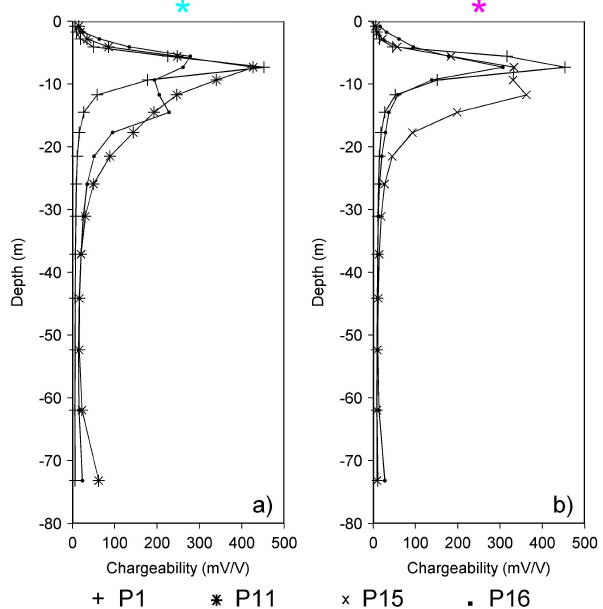
Fig. 7. Extracted models from the inverted surface measurements crossing the landfill. The stars refer to the locations on the map in Fig. 1. (a) 1-D models from profiles 1, 11 and 16. (b) 1-D models from profiles 1, 11 and 15.